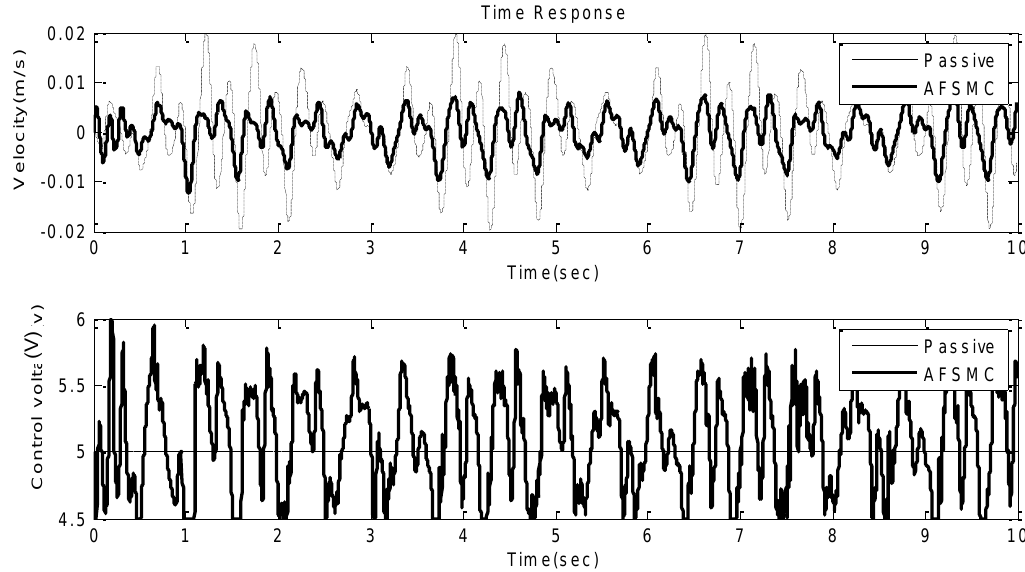
Figure 8. Time domain velocity response (upper) and control voltage (lower) of the passive and AFSMC-active isolator under random